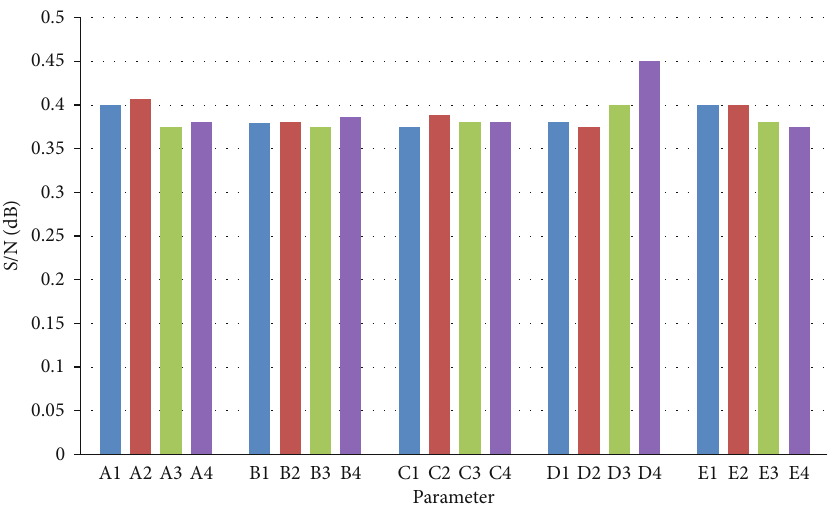
Figure 7: Variation of the S/N ratio with factor level for warpage phenomenon of thin-walled part by numerical simulation.